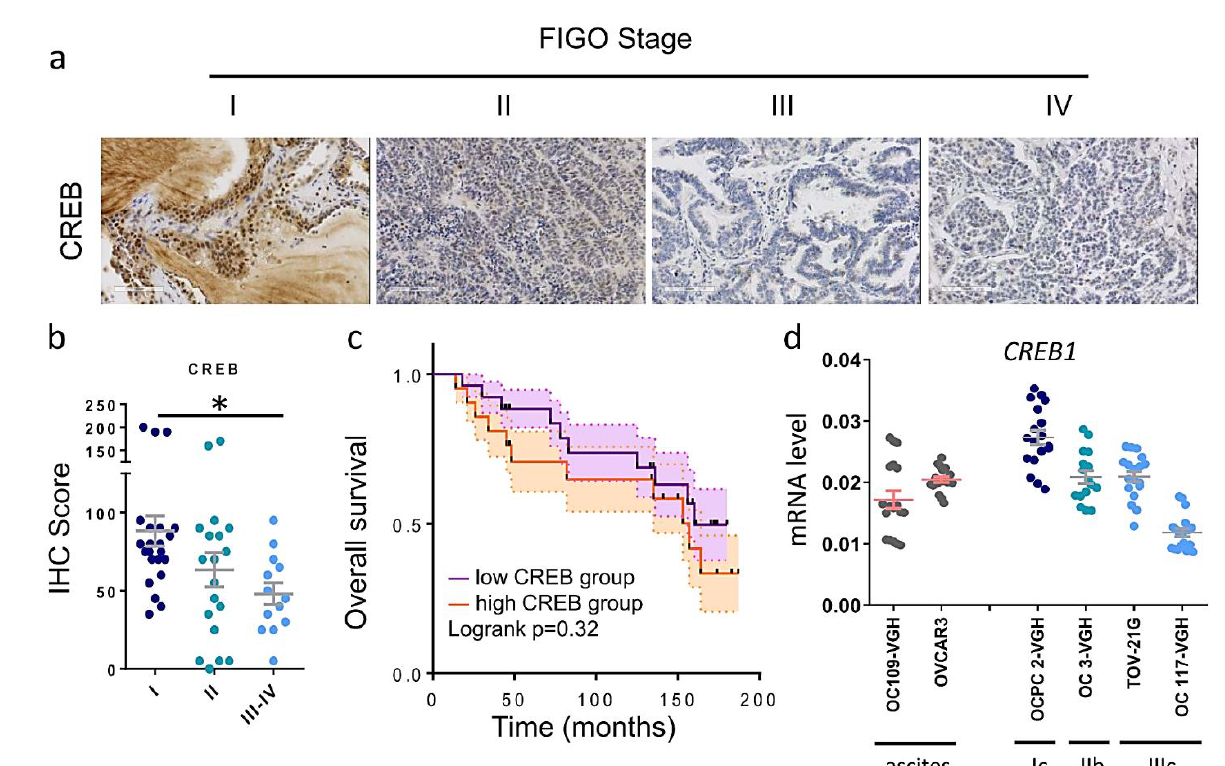
Figure 4. Immunoreactivity of CREB in OV. ( a ) The representative photomicrographs of CREB expression for weak (+), and strong (+++) staining in OV tissues ( n = 59). ( b ) The IHC score of CREB expression in OV tissue. ( c ) Kaplan–Meier curves were performed to determine differences in OV patients. ( d ) RT-PCR was used to detect the expression levels of different ovarian cancer cells, and U6 small nuclear 1 (RNU6-1) was used as an internal control ( n = 18). * p < 0.05.